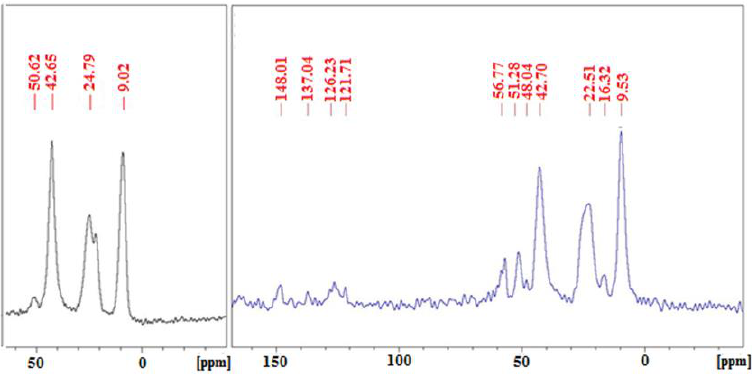
Figure 4. 13 C-NMR spectra of (SiNH 2 ) and (SiNTh-Py).